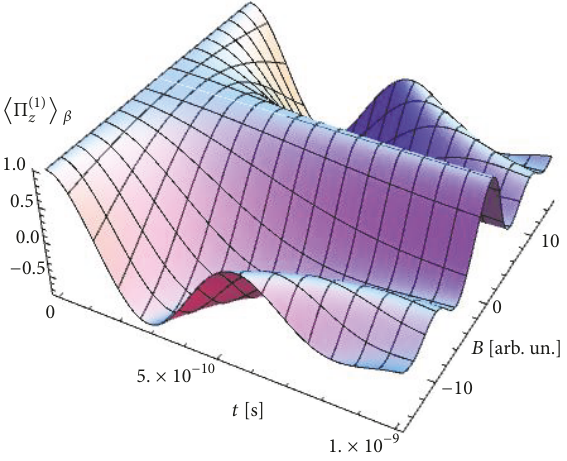
Figure 7: Thespin polarization ⟨Π 𝑧 (𝑡)⟩ 𝛽 as functionof themagnetic field and time for 𝑇 = 300 K and 𝜌 = 𝜖 𝑠 × 10 9 s −1 , with 𝑠 = 0.2 .